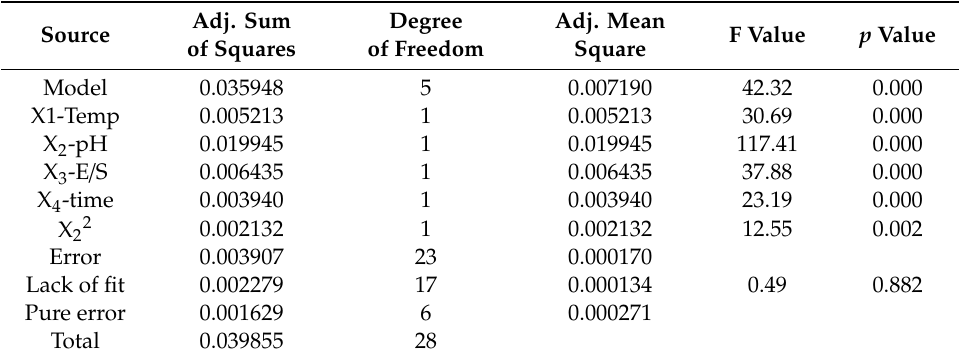
Table 4. ANOVA for the lineal model for level optimization of PGOs using C. thermocellum